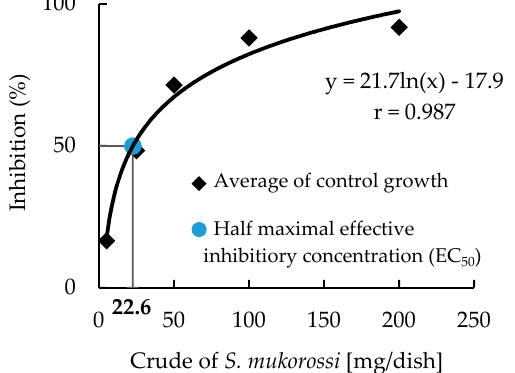
Figure 6. The effective concentration that induces half-maximal inhibitory activity (EC 50 ) of the radicle growth inhibition and the crude amount of dry plant samples of S. mukorossi on test plant L. sativa , with 41 mm distance and 72 h time consideration.